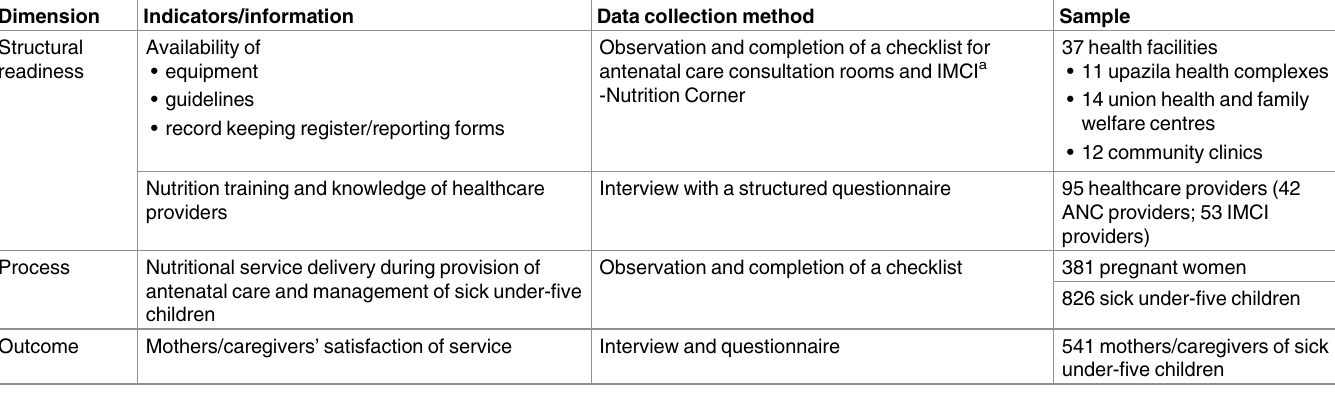
Table 1. Adapted Donabedian model to assessthe quality of nutrition services/ indicators, sample and data